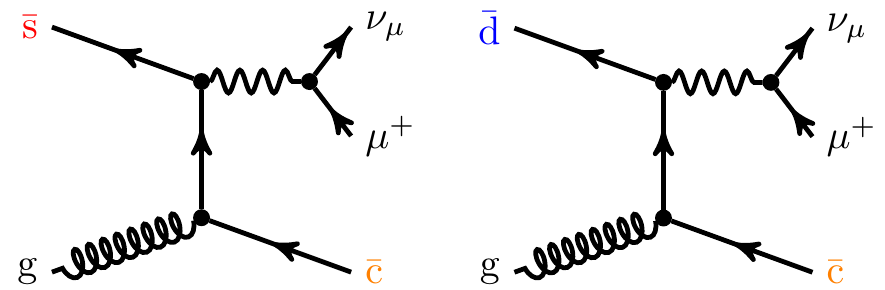
Figure 1: Feynman diagrams of pp → W + j and off-diagonal elements